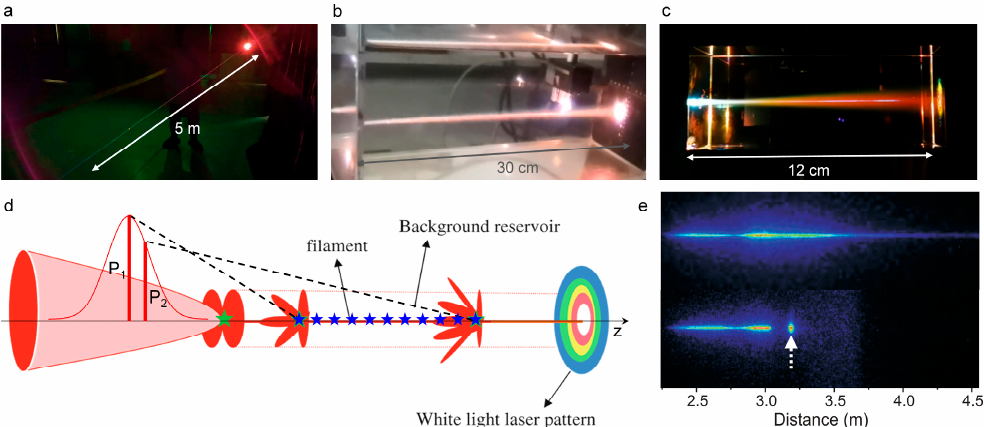
Figure 2. Physical mechanism of femtosecond laser filamentation. ( a – c ) Femtosecond laser filamentation in air ( a ), liquid ( b ), and solid ( c ). ( d ) Schematic diagram of the evolution of a femtosecond laser pulse propagating in an optical medium that is based on the moving focus model. The central slice of the pulse self-focuses to a small area where the resulting high intensity ionizes the air molecules (blue star) [1]. ( e ) Background reservoir effect on filamentation: fluorescence images of the filaments without and with a pinhole (white arrow) [30].